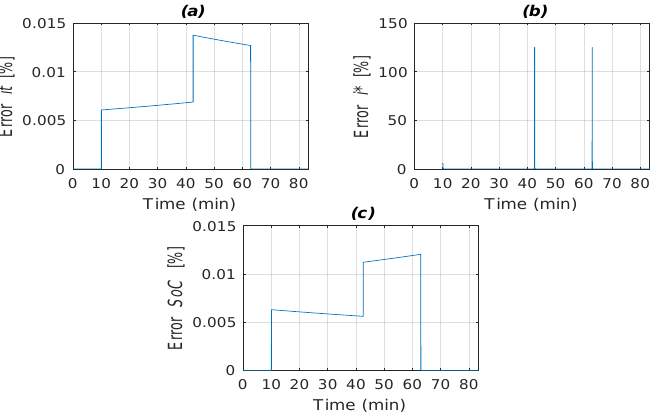
Figure 10. Percentage errors of: ( a ) it , ( b – c ) comparison of i ∗ and SoC signals obtained.